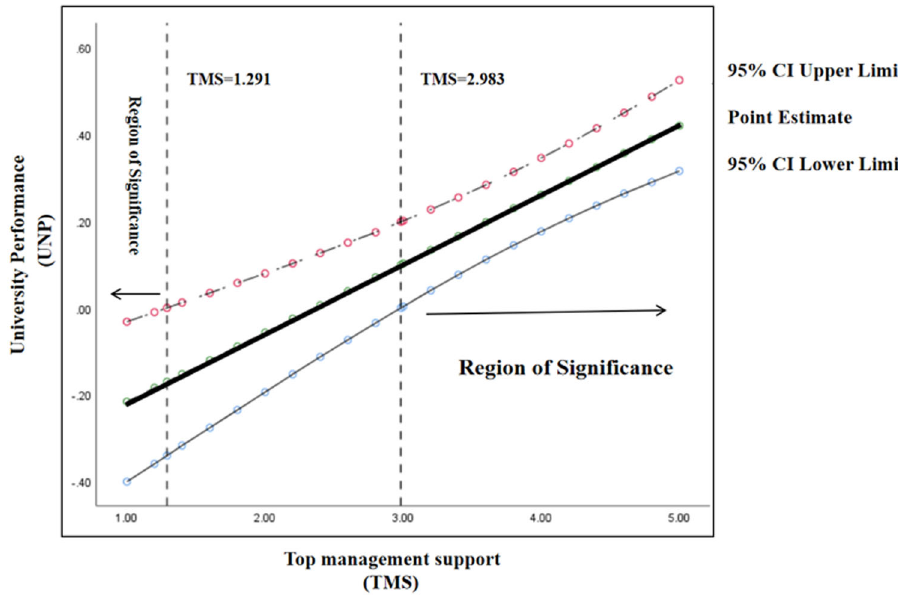
Fig. 3 Moderation effect of TMS (Johnson – Neyman analysis). The moderating effect of top management support based on the Johnson-Neyman slope and the region of signi fi